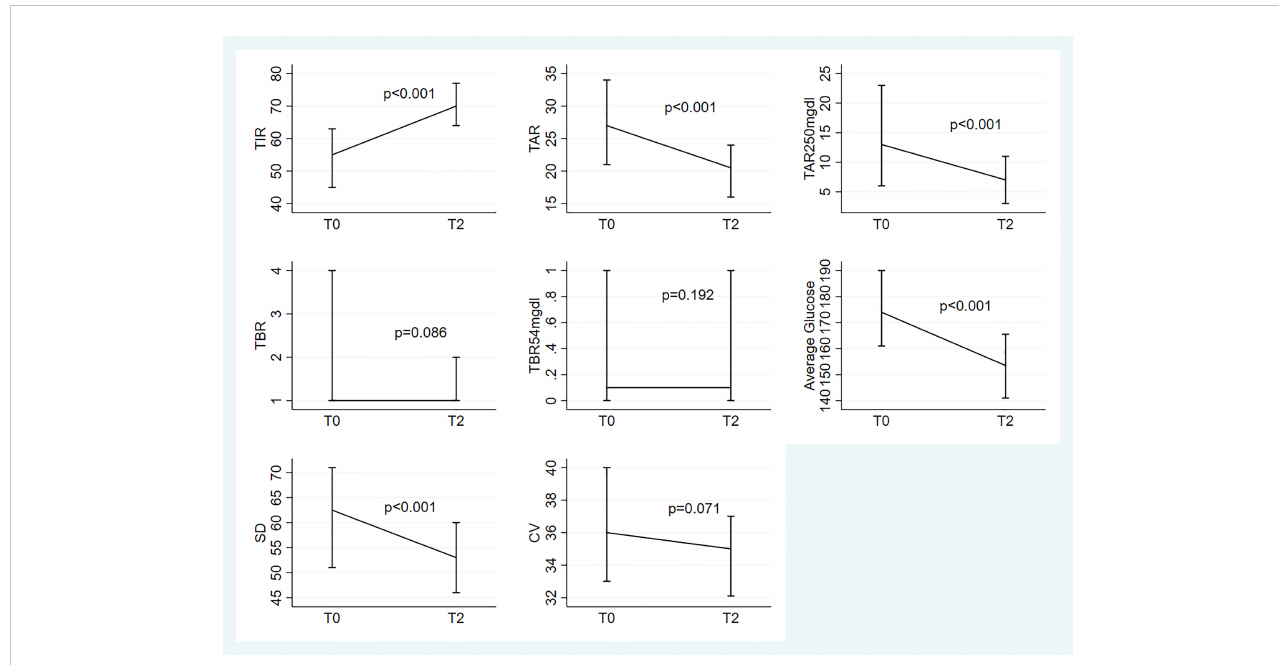
FIGURE 1 Median(IQR) at To and T2 for the 8 parameters under study; evaluation of the change from T0 based on the linear mixed models with random intercept adjusted for the following baseline variables: age, disease duration, HbA1c and type of previous